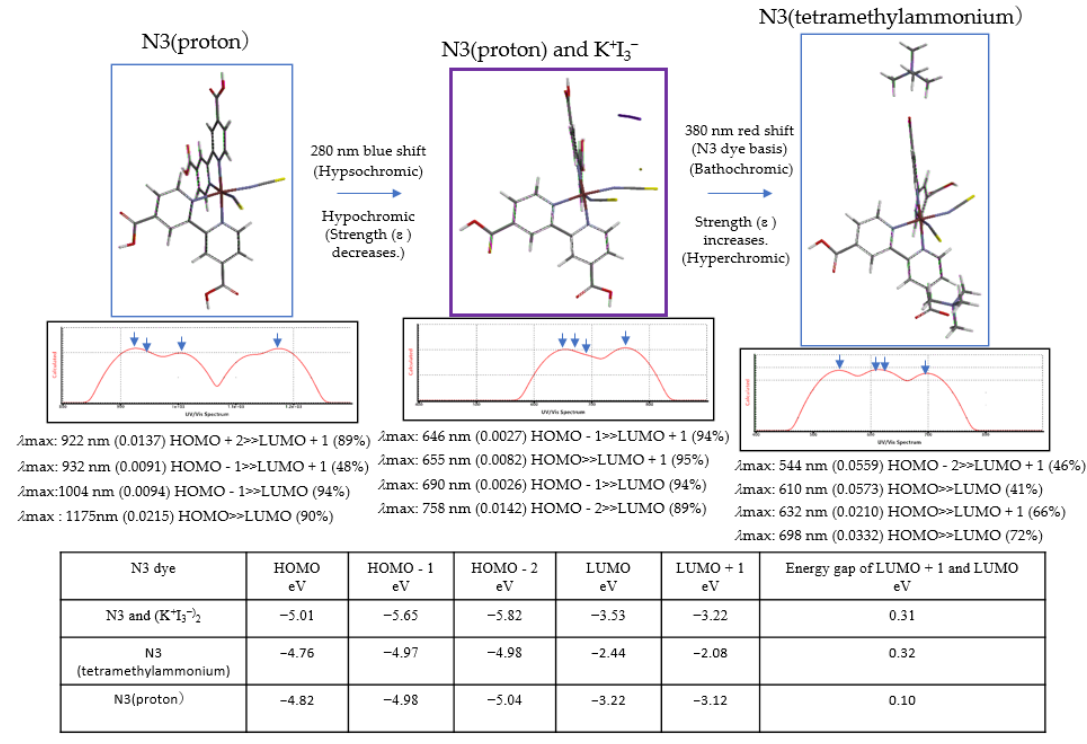
Figure 12. Comparison of DFT / MM-predicted UV-Vis spectra and energy structures of TiO 2 sensitizing dyes of N3 (proton), N3 (proton) and K + I 3 − and N3 (tetramethylammonium).